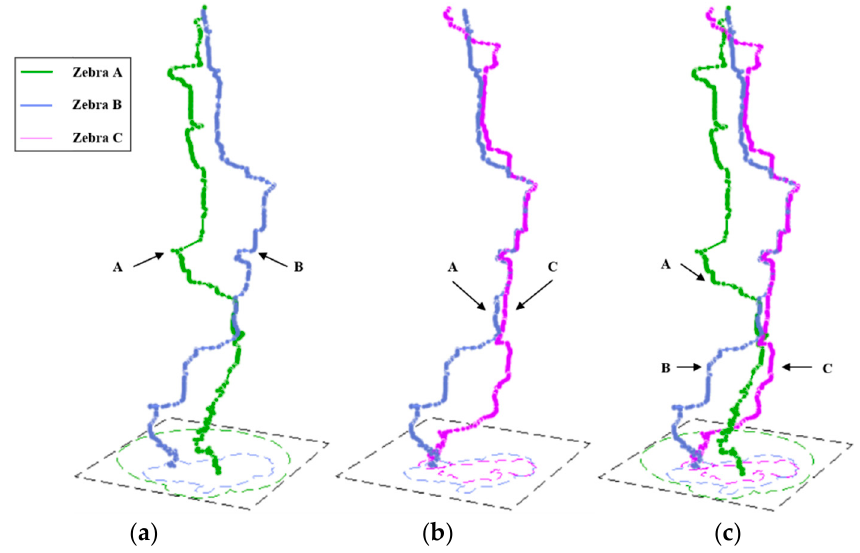
Figure 4. Trajectory data for three zebras: ( a ) A–B; ( b ) A–C; ( c ) A–B–C.